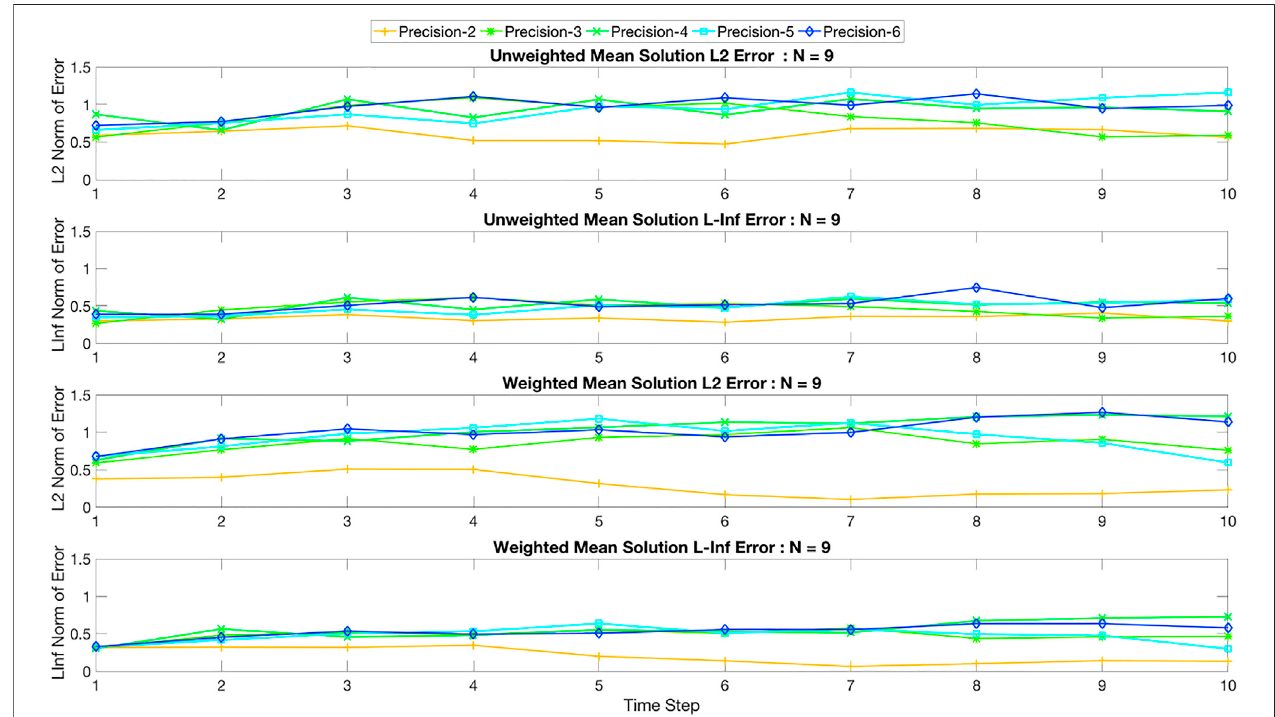
FIGURE 10 | L 2 and L ∞ errors of the unweighted and weighted mean solutions for a problem with nine grid points. The precision varies from 2 to 8 and the error is computed for each time step.